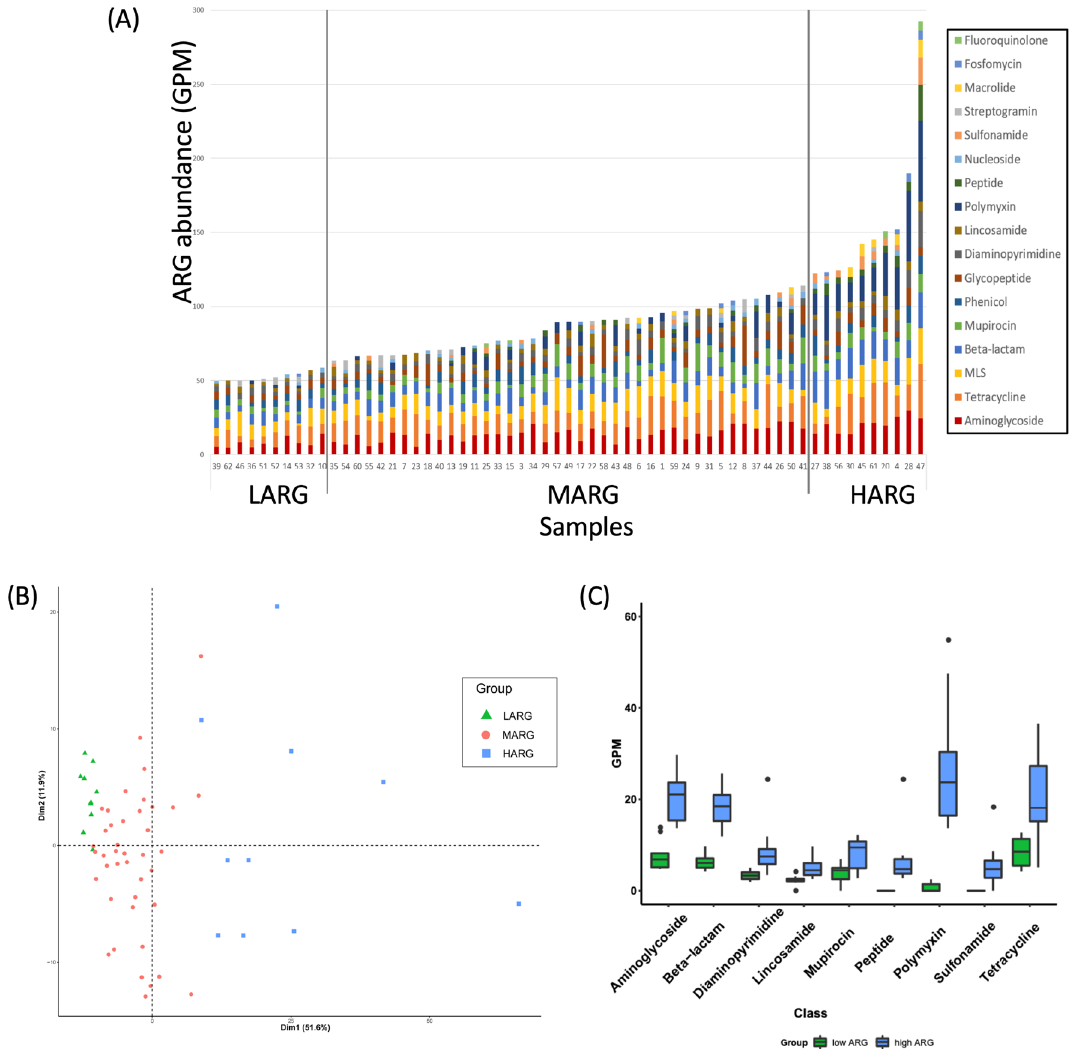
Figure 1. Distribution of antibiotic resistance determinants in the guts of healthy Korean subjects. ( A ) The distribution of resistance determinants in LARG, MARG, and HARG groups. Sample numbers are shown in x-axis. HARG consisted of 10 subjects who had a higher abundance (> 120 GPM) of antibiotic resistance genes. LARG consisted of 10 subjects that had lower abundance (< 60 GPM) of antibiotic resistance genes. MARG was between LARG and HARG, which had ARGs of higher than 60 GPM and lower than 120 GPM ( B ) Principal component analysis of resistance determinants in HARG, MARG and LARG. ( C ) Nine antibiotic determinants were significantly enhanced in HARG of the two groups ( P -value < 0.01). HARG high antibiotic resistance genes group, MARG middle antibiotic resistance genes group, LARG low antibiotic resistance genes